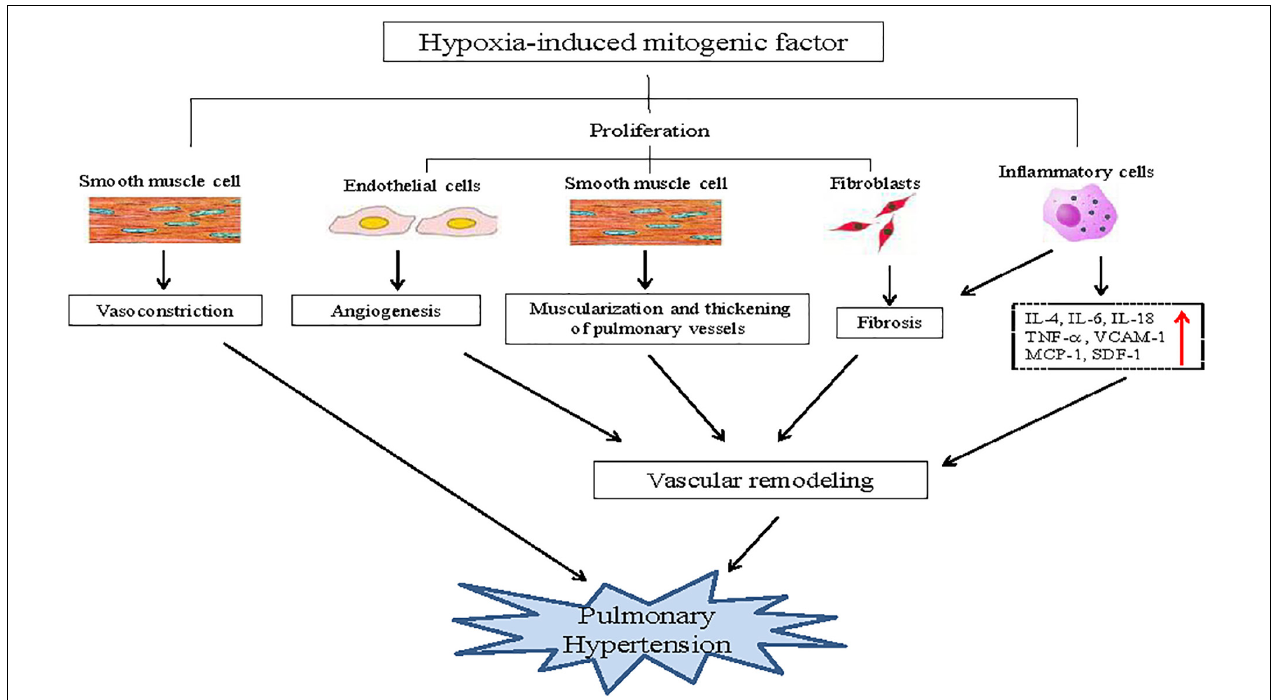
FIGURE 2 | Role of HIMF in hypoxia-induced pulmonary hypertension. HIMF induces pulmonary vasoconstriction, which plays a critical role in pulmonary hypertension. Simultaneously, HIMF also induces the proliferation of pulmonary arterial endothelial cells, smooth muscle cells and fibroblasts, which leads to angiogenesis, muscularization, the thickening of small pulmonary vessels, fibrosis, and subsequent vascular remodeling. Furthermore, HIMF induces inflammation in the lungs, which also promotes vascular remodeling and lung fibrosis, contributing to the pathological process of pulmonary